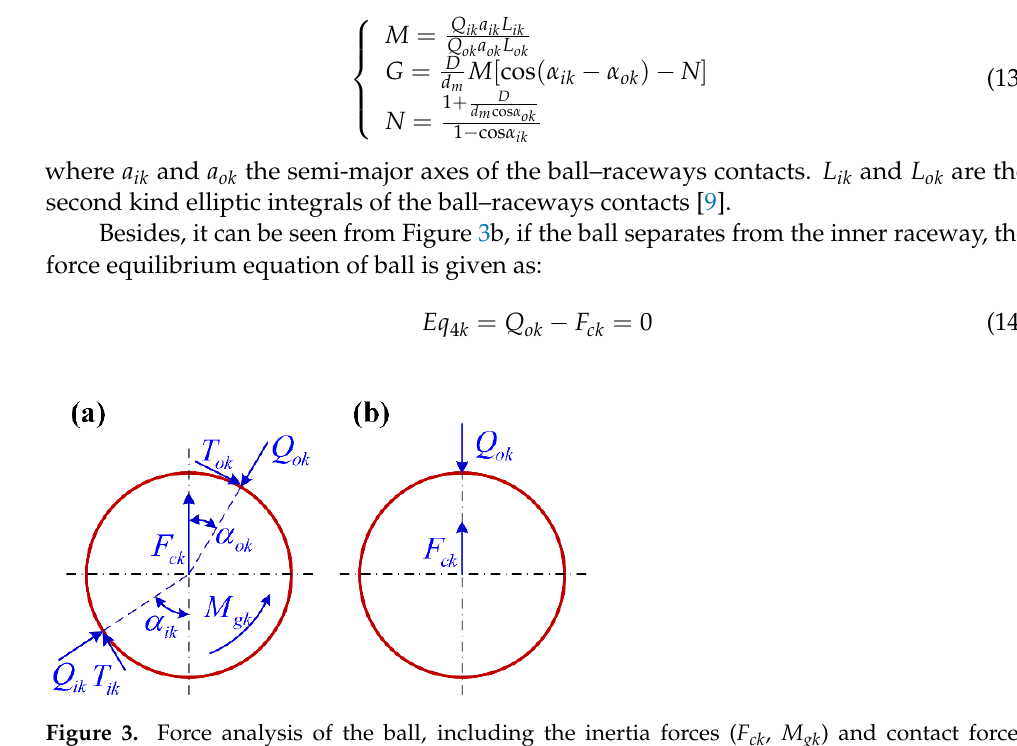
4 unknown variables ε k = { X 1 k , X 2 k , δ ik , δ ok } in Equations (2) and (3). The